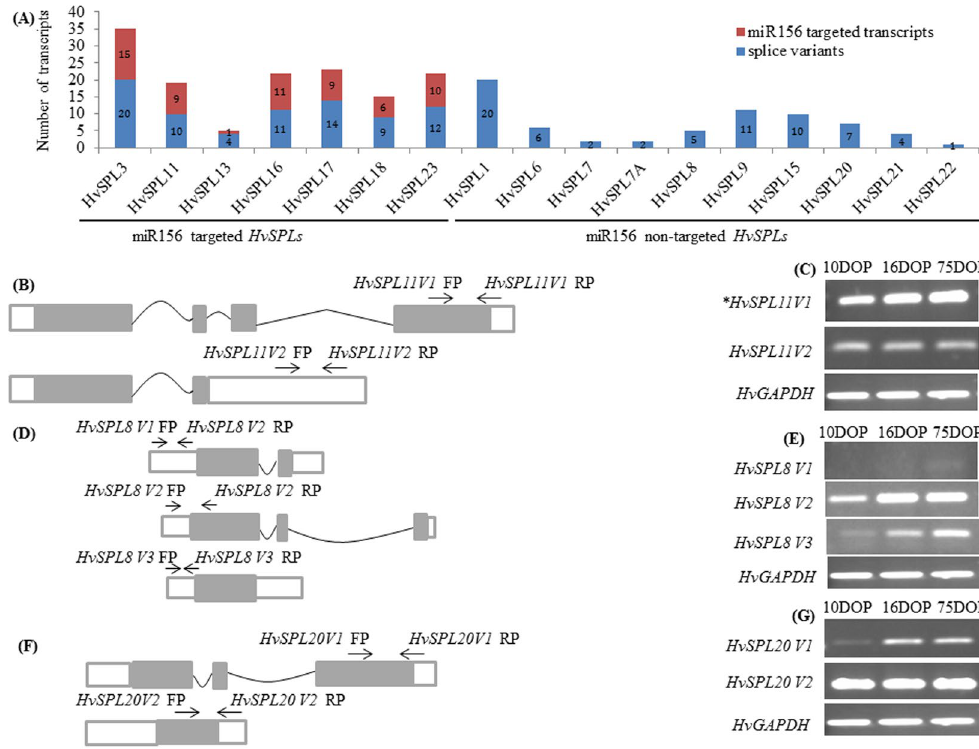
Figure 3. Alternative splicing event in HvSPL genes and expression analysis. ( A ) Number of Splice variants in HvSPL genes and miR156 target site distribution. ( B , C ) The splice variants of barley SPL11 and their expression pattern in 10, 16 and 75 day old plant. The two variants ( SPL11 V1 and V2) expressed differentially. ( D , E ) Splice variant of barley SPL8 and their expression patterns. The three variants ( SPL8 V1, V2 and V3) of SPL8 expressed lower in juvenile and higher in reproductive phase. ( F , G ) Two splice variant ( SPL20 V1 and V2) of barley SPL20 and their expression patterns. * Asterisks denote the presence of the miR156 complementary sequence in the splice variants of barley SPL11 gene. The brown colour box represents coding region, black line denotes intron and the white rectangle denotes 5 ′ & 3 ′ UTR regions. The arrow shows the site of forward and reverse primers. For more clarity gel area showing relevant bands were cropped. The full-length gels are presented in Supplementary Fig.